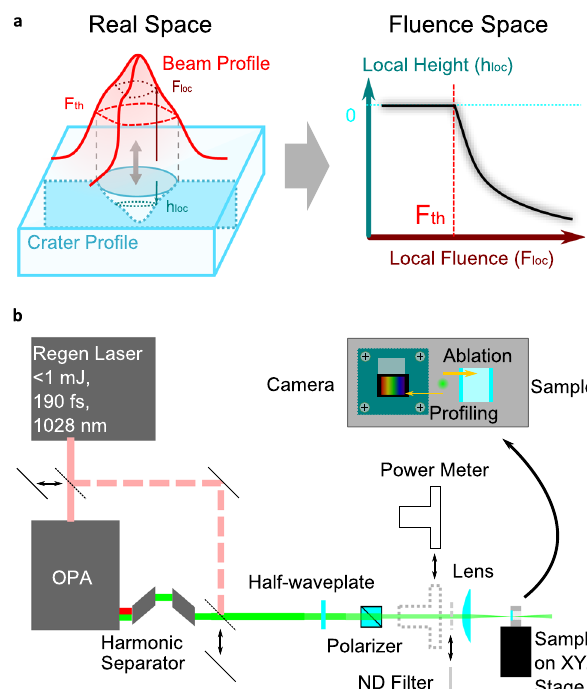
Fig. 1 Experimental overview and setup. a Overview of the fl uence mapping procedure, where the exact beam pro fi le and exact crater pro fi le are spatially correlated, after which the local heights are replotted as a function of the local fl uence. b Experimental setup. The light source was either the fundamental light of a regen ampli fi er, or an OPA pumped by it. The intensity of the light was adjusted, then subsequently focused onto a sample holder with an integrated CMOS camera on a XYZ stage. By laterally translating the holder, either the measurement of an in situ beam pro fi le at the focus or processing of the sample could be realized.